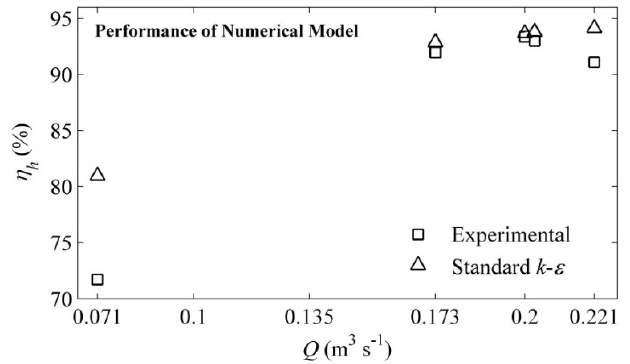
Figure 11. Comparison of experimental and numerical hydraulic efficiencies at five operating points [5].